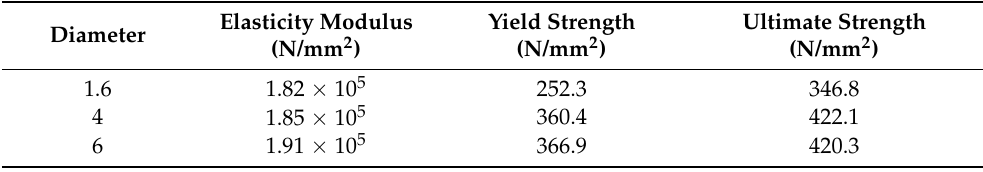
Figure 6. Shaking-table test model for four-story, infilled RC-planar-frame structure. ( a ) Plan view of first floor. ( b ) Plan view of other floors. ( c ) Reinforcement of column. ( d ) Reinforcement of beam. Table 1. Material properties for the reinforced bars.